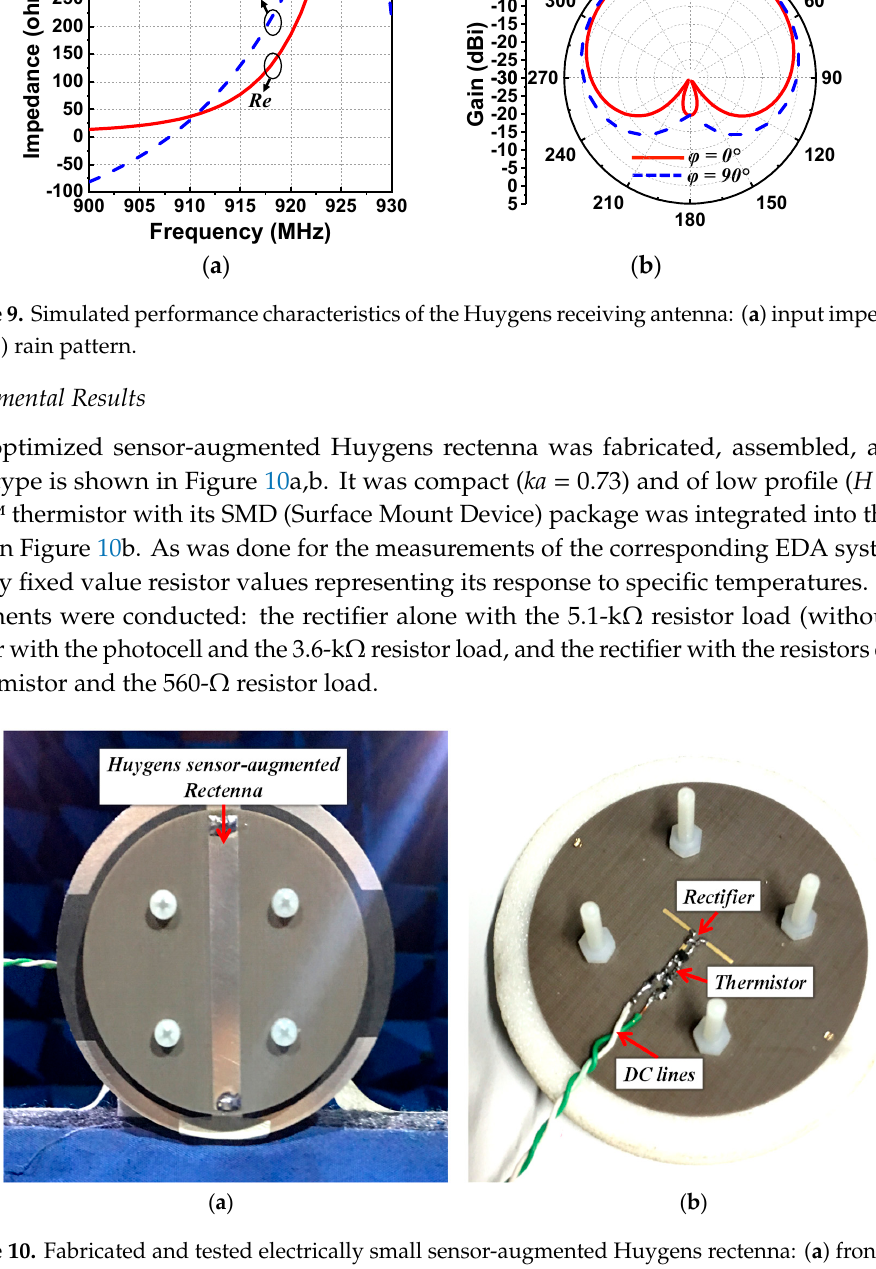
and ( b ) bottom view.